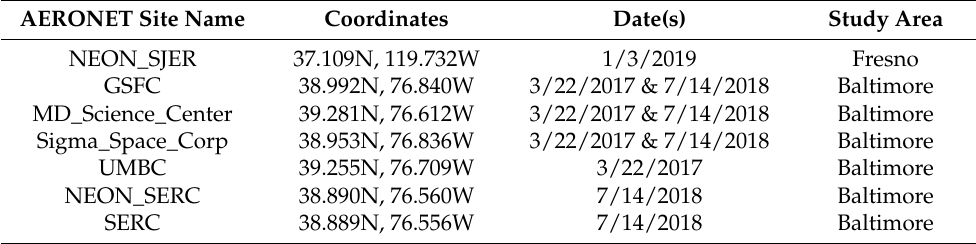
Table 3. Summary of AERONET data utilized for this study where latitude and longitude are given in N-S and E-W coordinates,